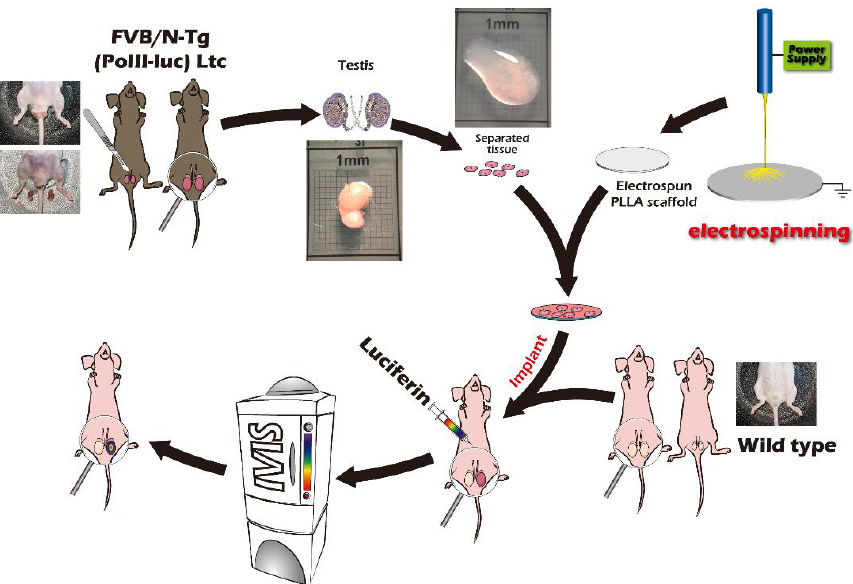
Figure 1. Schematic overview of the study design.